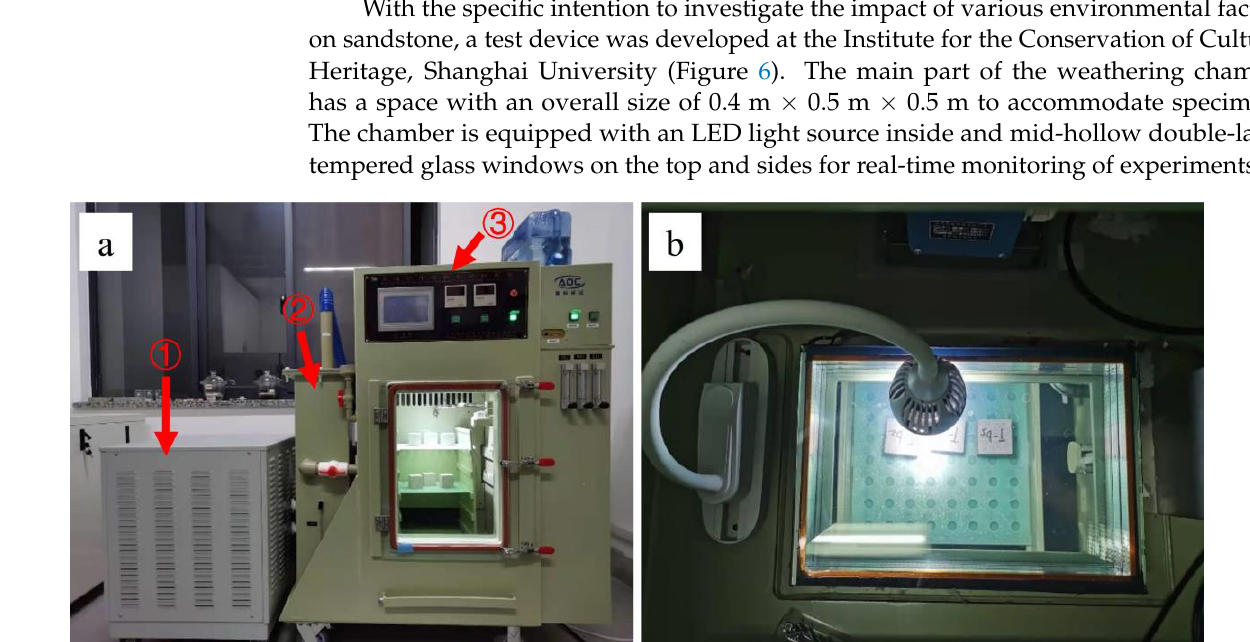
Table 4. Environmental parameters of artificially accelerated weathering tests.